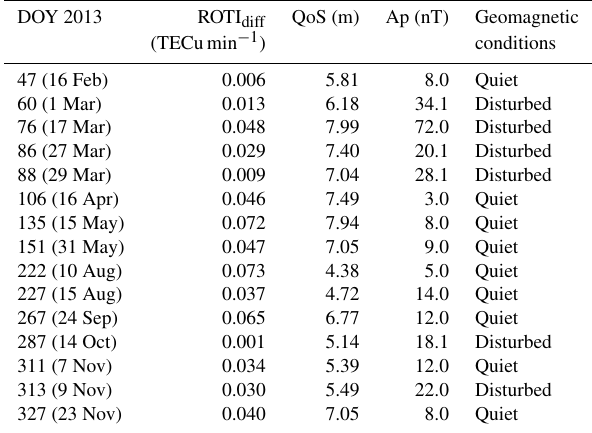
Table 1. Summary ionospheric irregularities and QoS during differ- ence geomagnetic